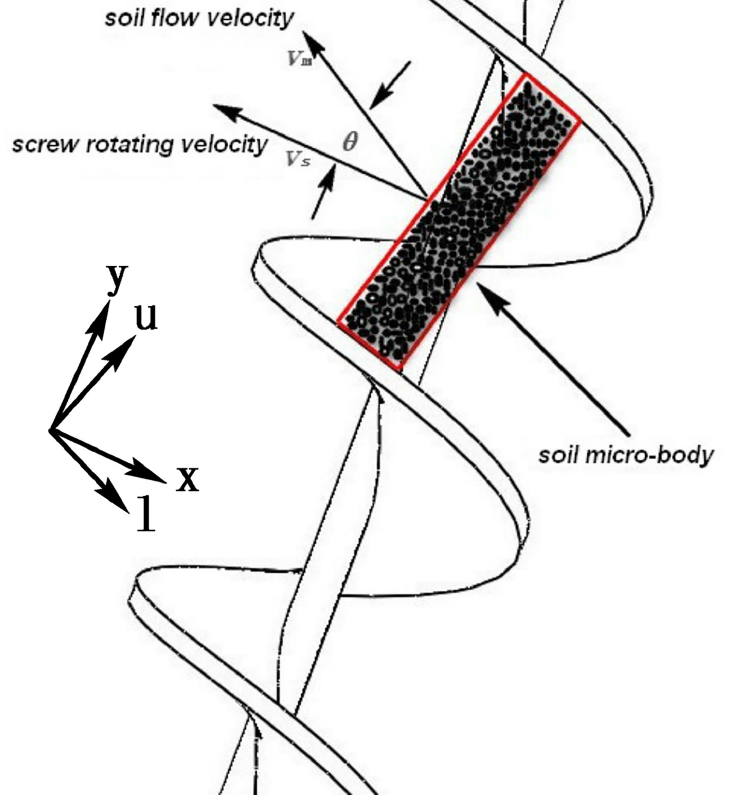
Fig 7. The movement of the soil microbody.